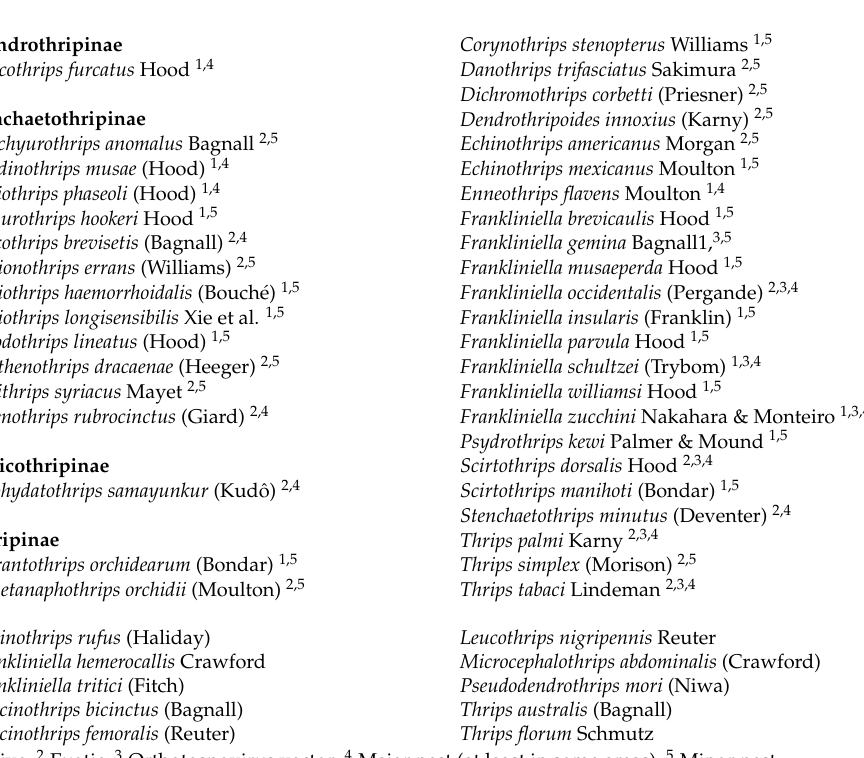
Table 2. ( A ) Pest Thripidae species in Brazil (by subfamily). ( B ) Introduced pest Thripidae of little economic importance in